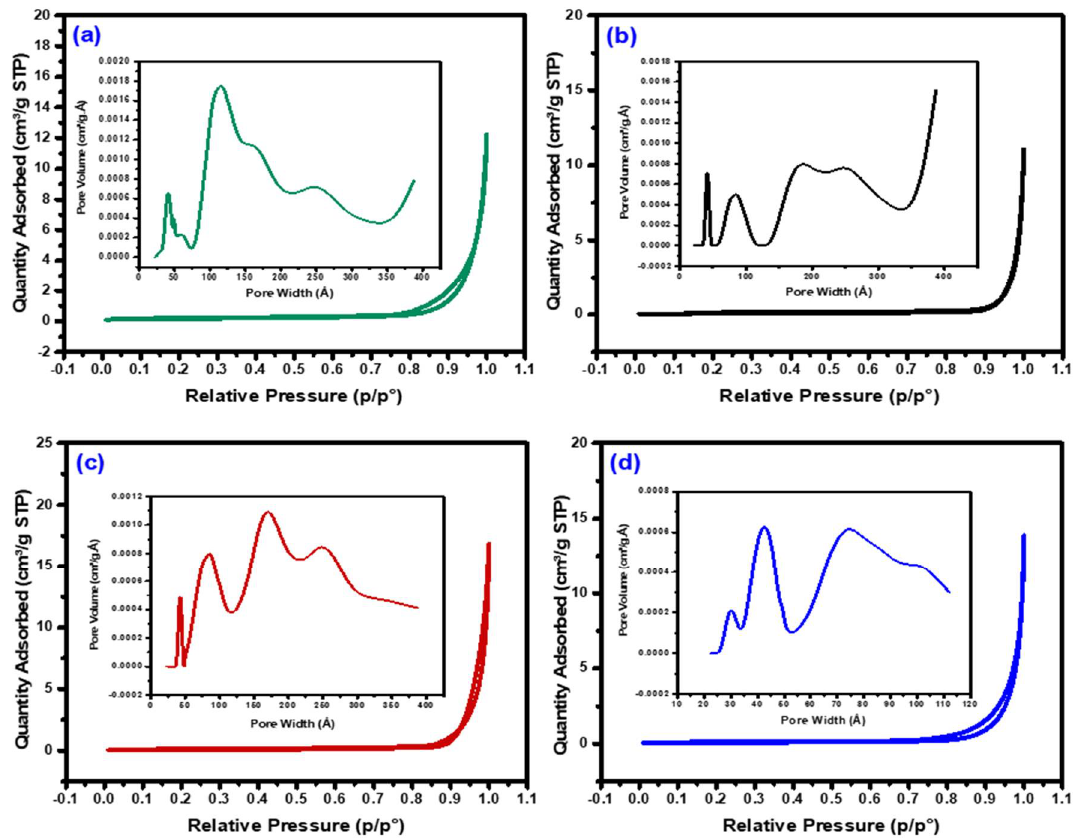
Figure 6. Nitrogen physisorption isotherms of the reduced samples: ( a ) Ni, ( b ) Ni-Co, ( c ) Ni-Fe, and ( d ) Ni-Cu.